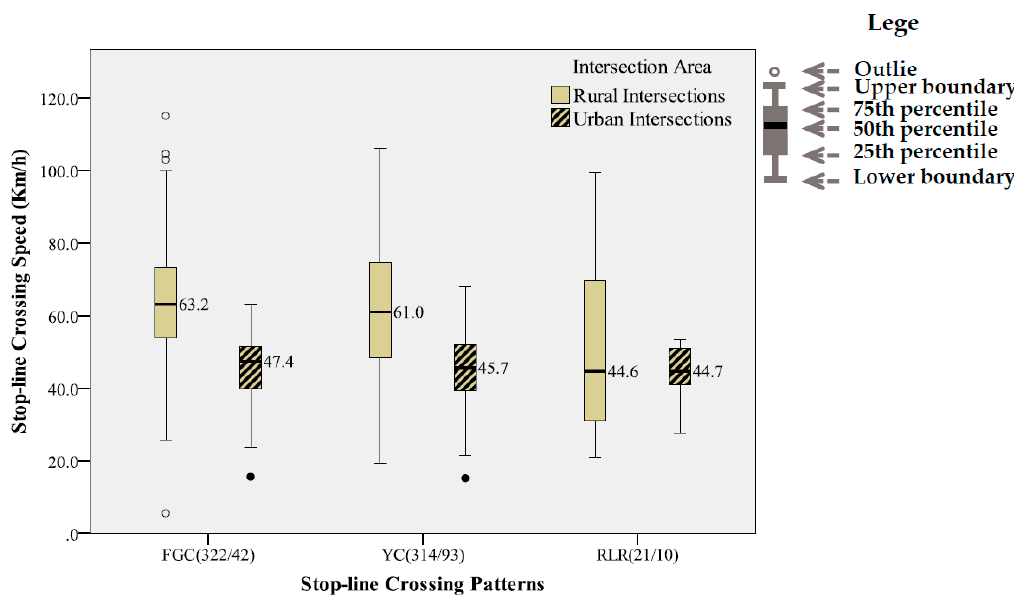
Figure 4. Boxplots of the stop-line crossing speeds for the FGC (crossing during the flashing green interval), YC (crossings during the yellow interval) and RLR (red-light-running) patterns.